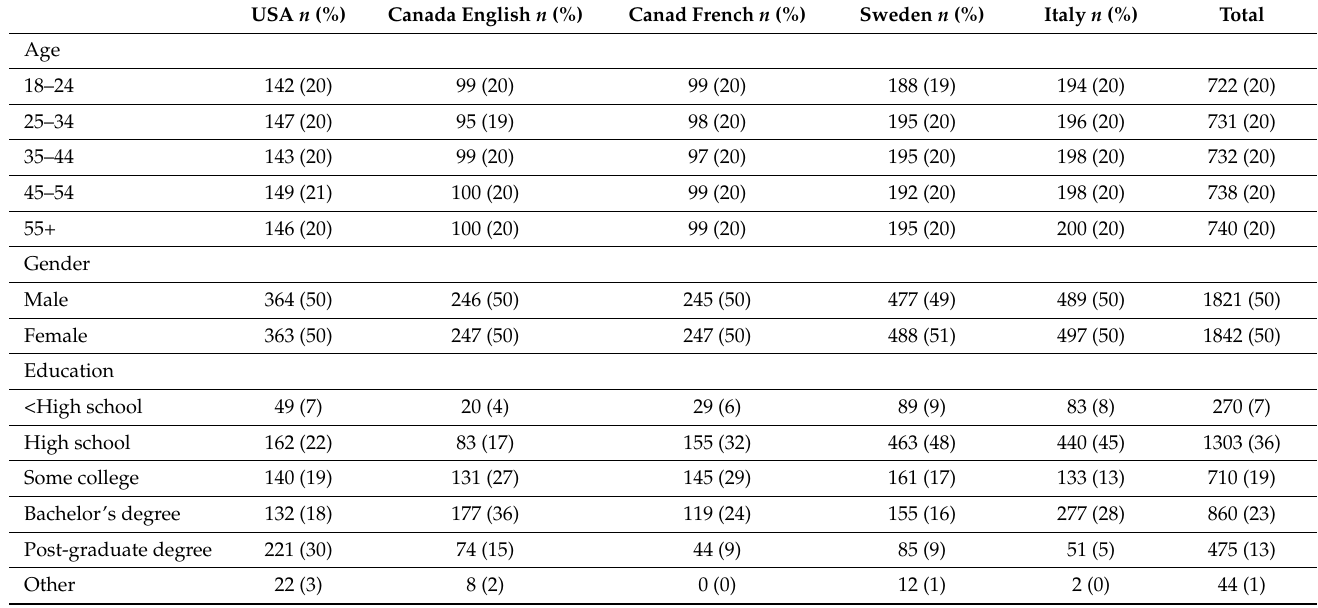
Table A1. Demographics and Subject